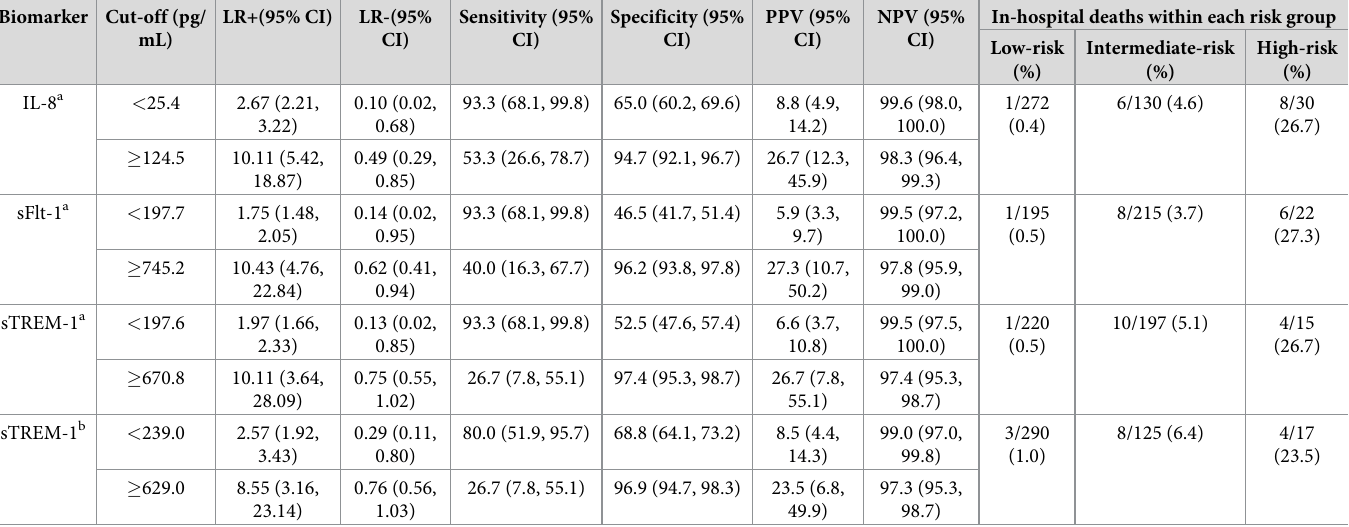
Table 4. Biomarker cut-offs for in-hospital mortality and performance estimators.